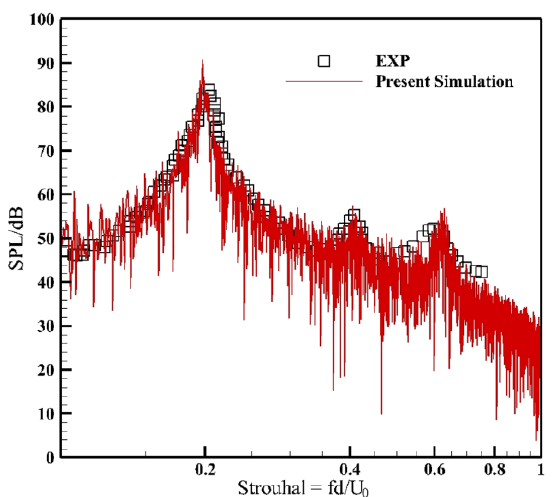
Figure 3. Acoustic pressure results compared with the experimental data [27] at (0.105, 0.5 πD, 18 5